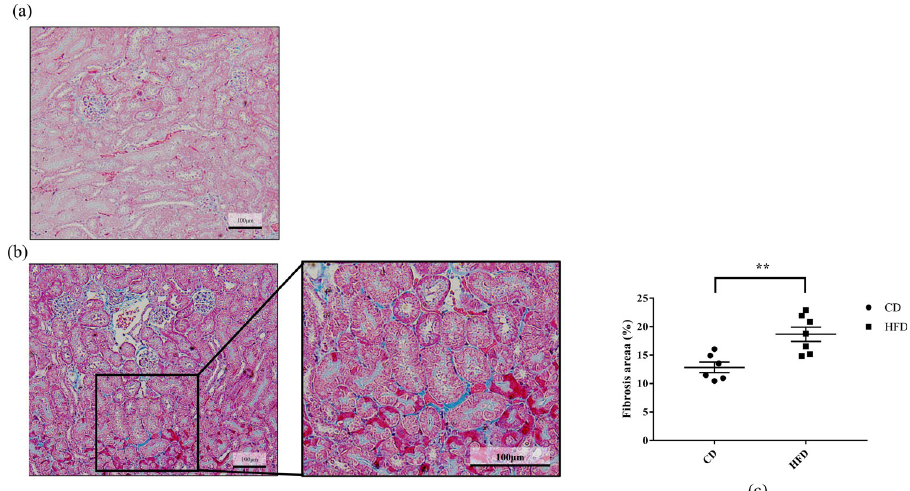
Fig 4. Effect of HFD on interstitial fibrosis. (a) Representative images of Masson trichrome-stained C57BL6/J mouse renal tissue sections. Mice are fed with (a) CD or (b) HFD for 16 weeks. (c) Quantification of the area of fibrosis. Results are expressed as the percentage of fibrotic area to the whole tissue area. The quantification is based on randomly captured five fields from the all mice. Bars indicate mean ± SEM. �� p < 0.01 (unpaired t-test). n = 6 in CD and 7 in HFD, respectively. CD, control diet group; HFD, high-fat diet group.